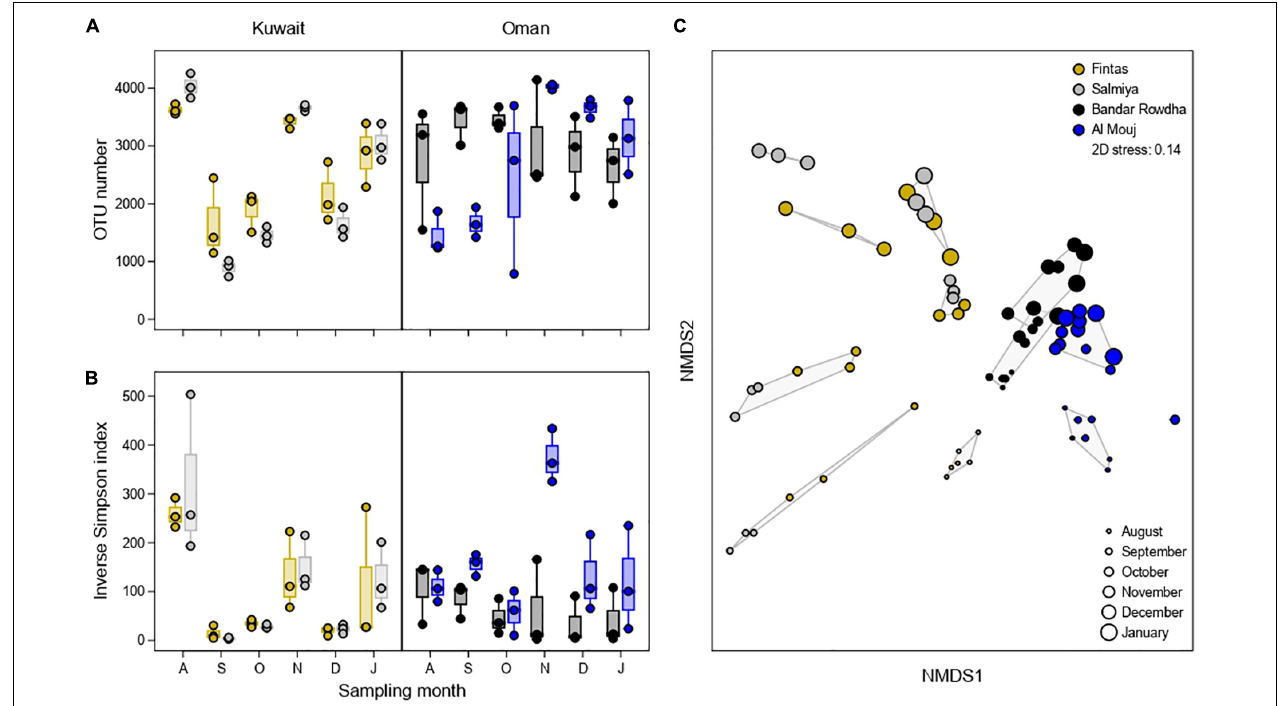
FIGURE 3 | Alpha diversity of the fouling bacterial community based on (A) OTU number and (B) Inverse Simpson Index at the sampling locations in Kuwait (Fintas and Salmiya) and Oman (Bandar Rowdha and Al Mouj) during the sampling period of 6 months from August 2017 to January 2018 (abbreviated as A, S, O, N, D, J). (C) NMDS ordination plot showing the segregation of fouling bacterial communities based on location and sampling time. Shaded hulls indicate groups of samples with a Bray-Curtis dissimilarity of < 0.8.